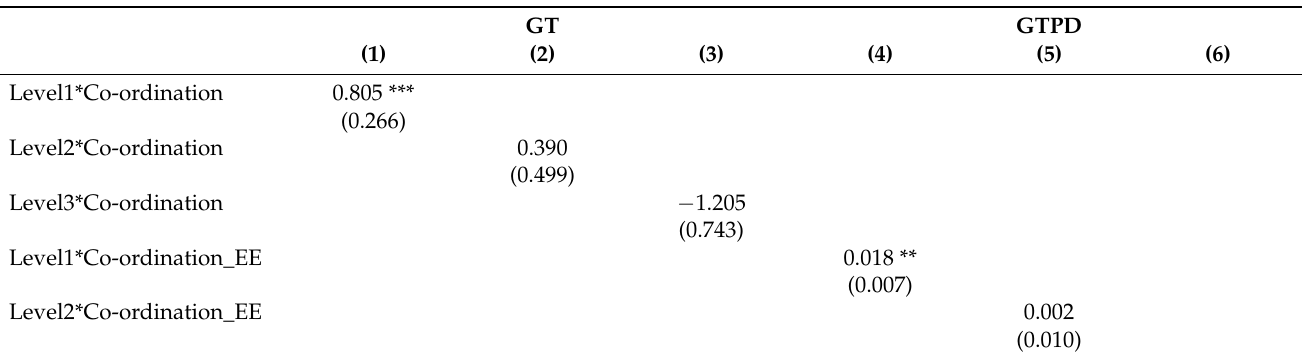
Table 5. Self-reinforcing effect test of co-ordinated development on green technology